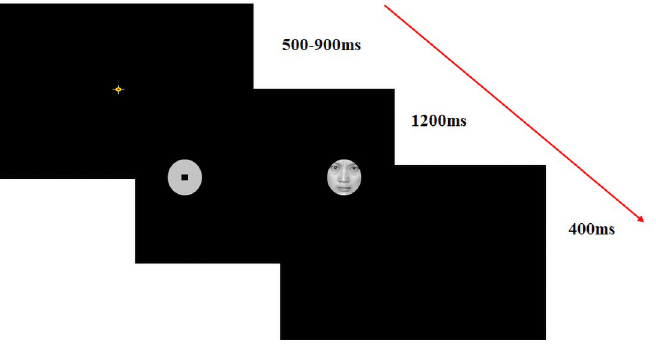
Fig 2. A schematic example of a distractor trial sequence in the RDP whereby an angry face distractor and the target were shown in peripheral vision away from the centre of the display screen.